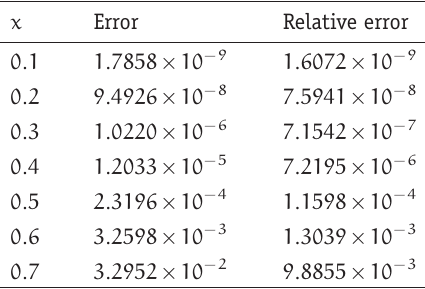
Table 3.1. Error obtained using Laplace transform numerical algorithm with four